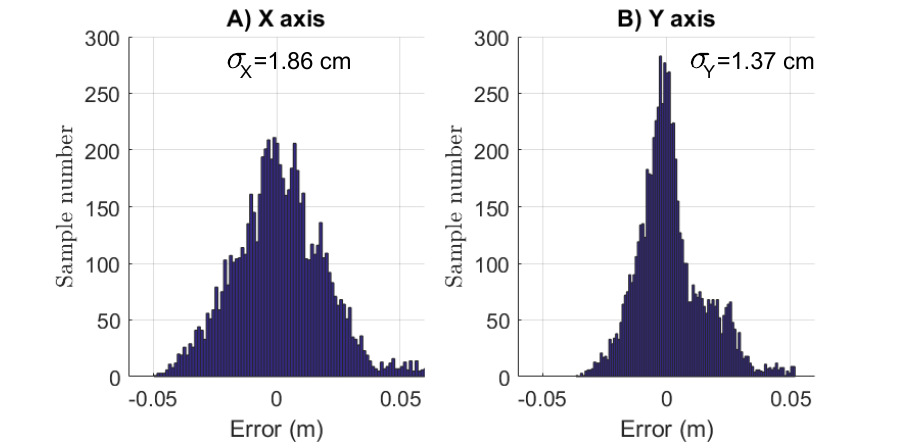
Figure 15. Histograms of the localization error in 2D using HyperCube. The standard deviations for the X and Y axis are σ X = 1.86 cm and σ Y = 1.37 cm for H = 2 m. Only one IR LED that flickers at 11 kHz is